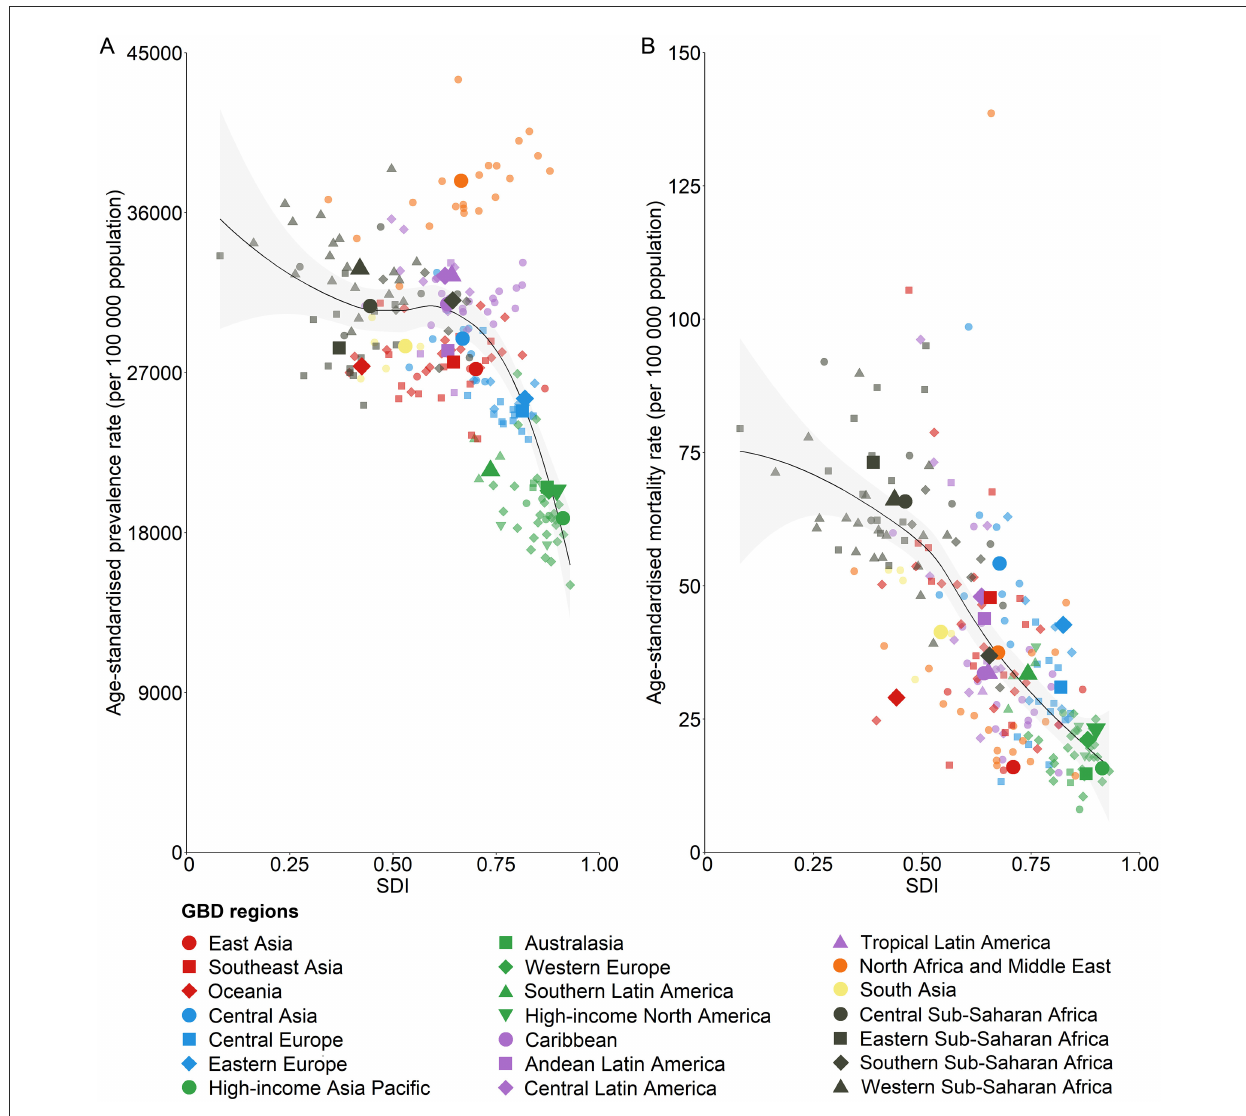
FIGURE5 The association between SDI and digestive disease age-standardized prevalence rate (A) and mortality rate (B) for both sexes combined, 2019. Each color represents one of the seven GBD super-regions (red represents southeast Asia, east Asia, and Oceania; blue represents central Europe, eastern Europe, and central Asia; green represents high-income; purple represents Latin America and the Caribbean; orange represents North Africa and the Middle East; yellow represents south Asia; and gray represents sub-Saharan Africa). Lighter-colored point estimates without labels in the legend represent countries. The black lines represent locally weighted smoothing based on country-level data, and the gray shading represents locally weighted smoothing of country-level 95% uncertainty intervals. GBD, Global Burden of Disease, Injuries, and Risk Factors Study; SDI, Sociodemographic